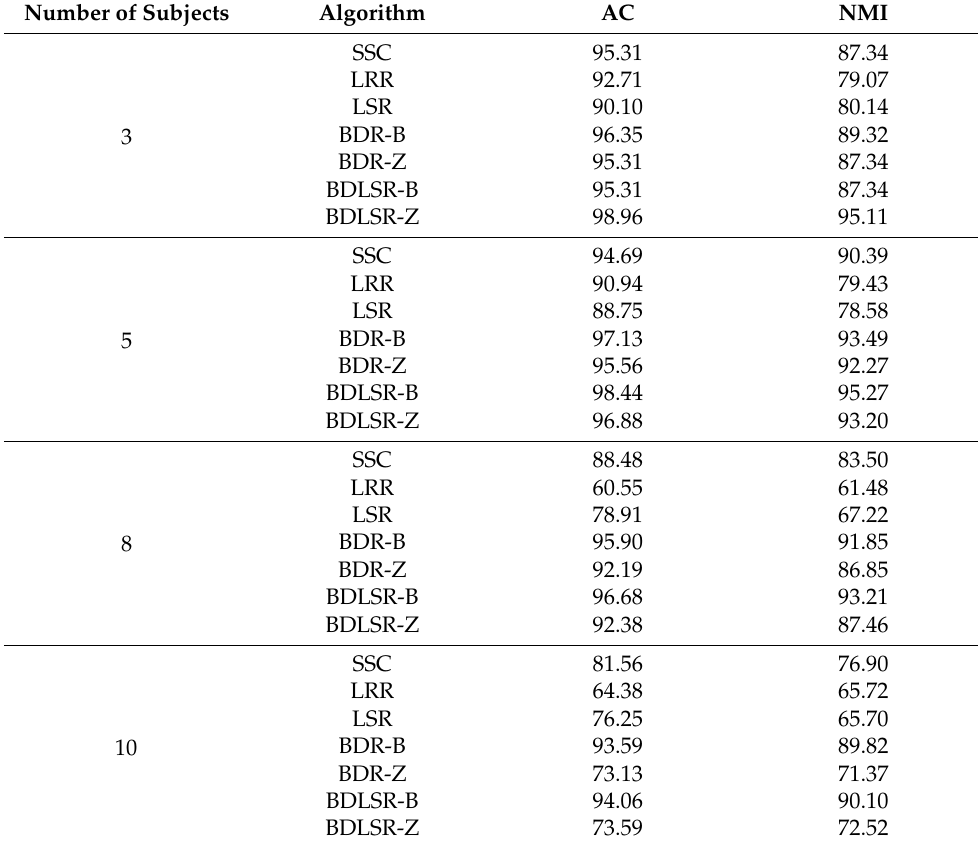
Table 5. The results from the different algorithms when using the Extended Yale B dataset